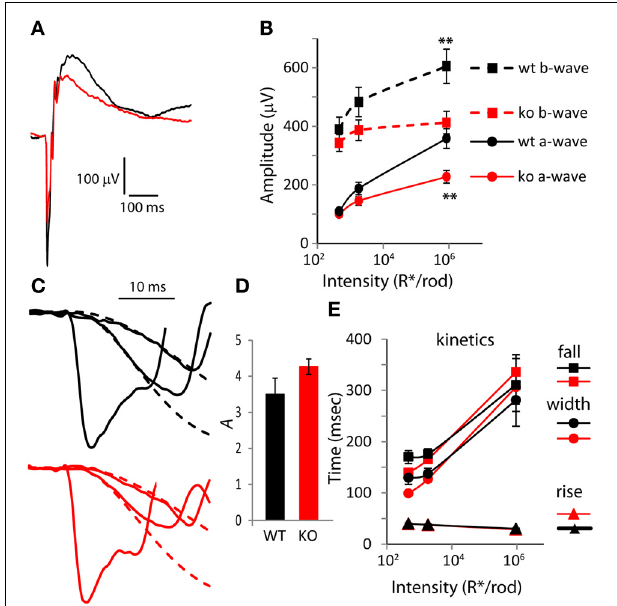
FIGURE 2 | The amplitude of the a-wave is smaller in PDE9A KO but its kinetics is largely unaffected. (A) Average response from WT and KO retinas to a rod saturating flash ( ∼ 10 6 R ∗ /rod). (B) Average a-wave and b-wave amplitudes (dark-adapted, rod and cone generated responses). Both a-wave and b-wave amplitudes in KO ( n = 14 mice for all intensities) are significantly different from WT ( n = 12) at the two highest intensities. Unless otherwise stated, for all figures, “ ∗ ” designates p < 0 . 05 and ∗∗ p < 0 . 01. (C) Expanded ERG responses from a KO and WT animal at the flash intensities in (B) showing the a-waves and their Lamb and Pugh curve fits (red and black dashed lines for KO and WT, respectively). The Lamb and Pugh equation was fit to the average a-wave from both eyes of the animal to estimate the amplification constant. (D) The Lamb and Pugh amplification constants as estimated by regression in WT and KO animals are similar. (E) The time taken by the b-wave to rise and fall to 66% of its amplitude and the duration (width). For the highest intensity, the b-wave fell to 66% of its amplitude only in 50% of WT and in 82% of KO.